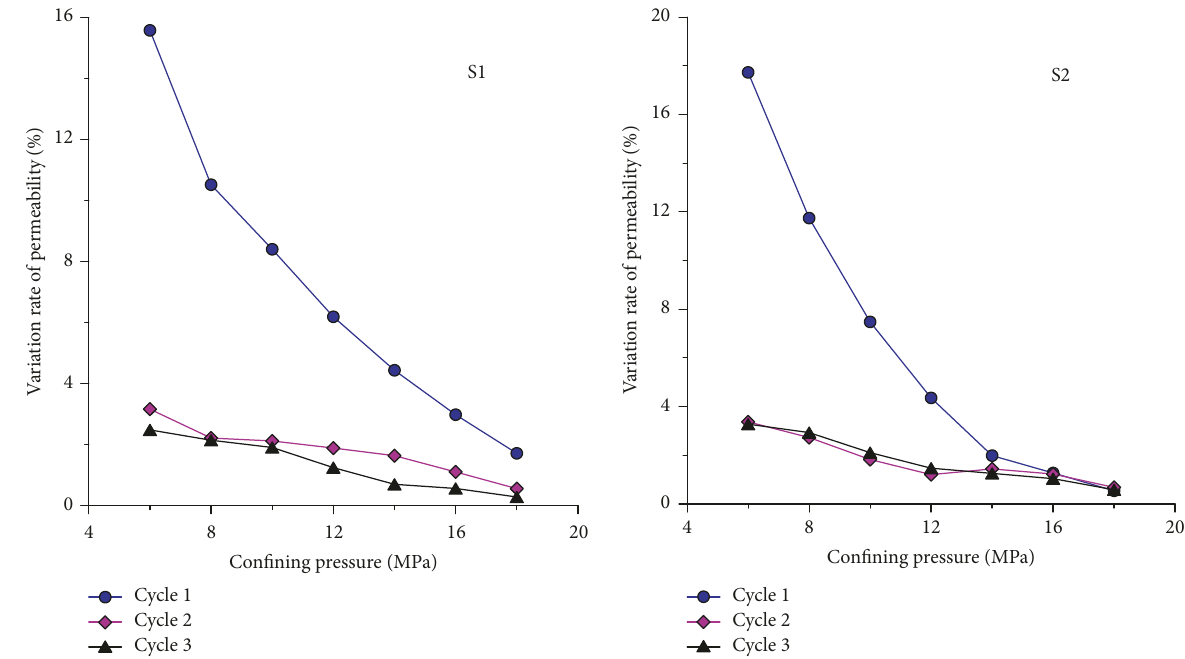
Figure 9: The relationship between changes in permeability and confining pressure in each